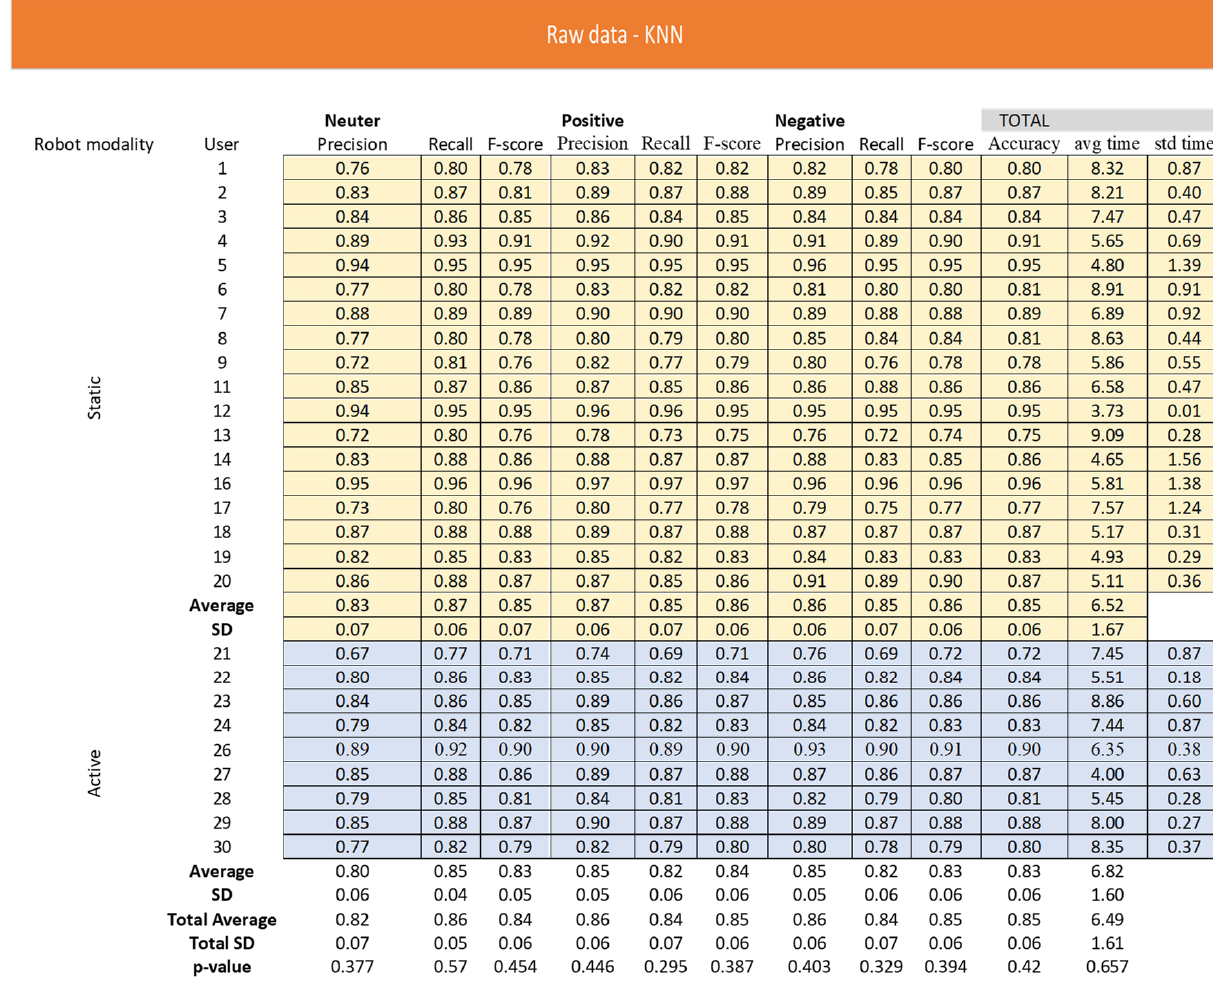
Figure 5. Raw representation according to KNN algorithm.